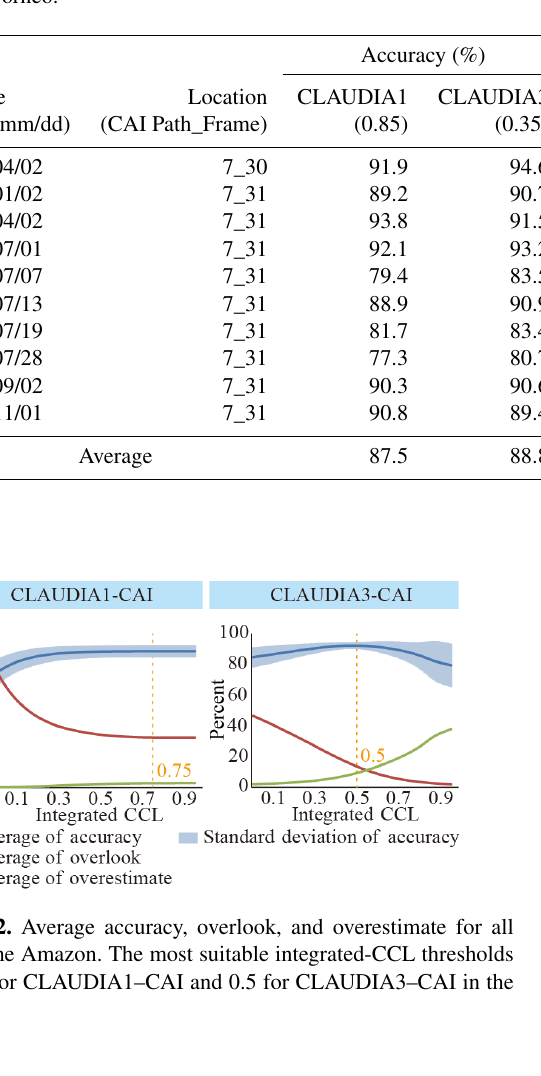
Table 8. Results for integrated-CCL thresholds of the maximum accuracy values in Fig. 13 (CLAUDIA1–CAI: 0.85, CLAUDIA3–CAI: 0.35) in Borneo.